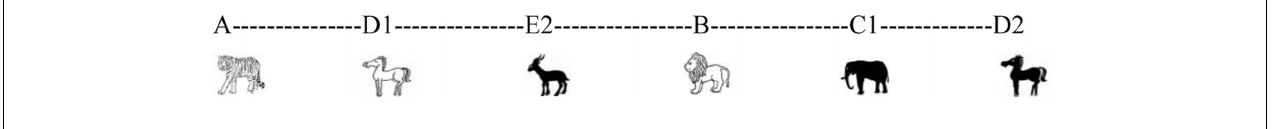
FIGURE 2 | Example of